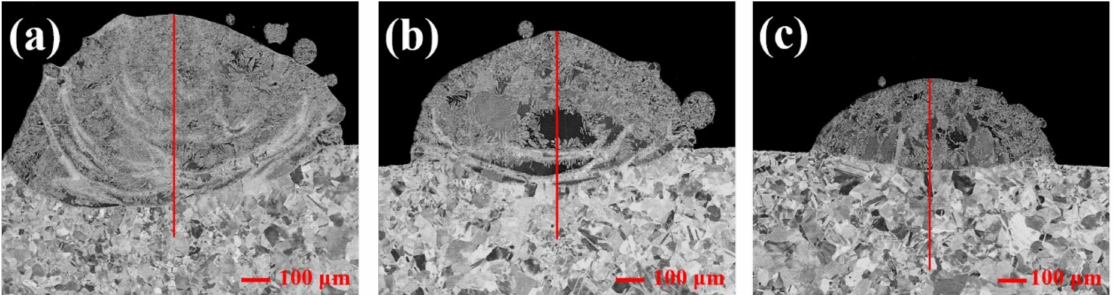
Figure 3. Melt pool shape of Fe-Cr-Si single-line clads at various laser traverse speed: ( a ) 12 mm/s, ( b ) 14 mm/s, and ( c ) 16